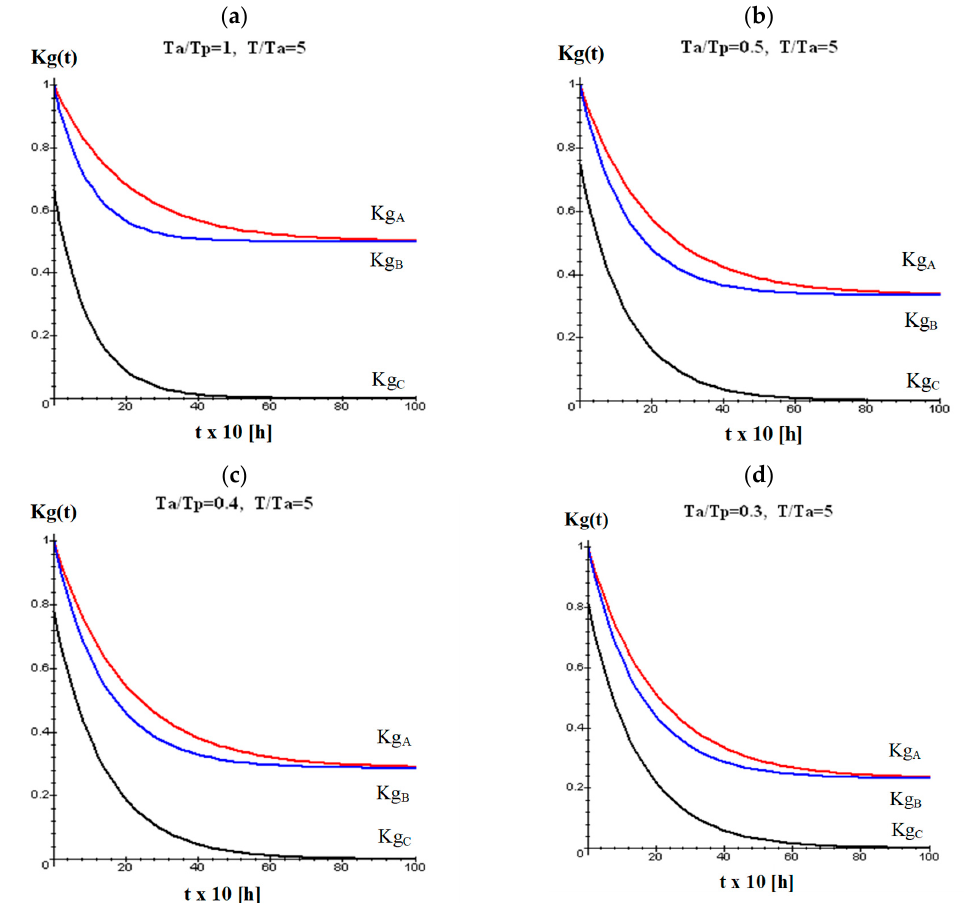
Figure 8. Courses of readiness function K g (t) in the operation process of wind power plant which uses various models of maintenance systems for condition T/T a = 5. Symbol in the Figure 8. represent: